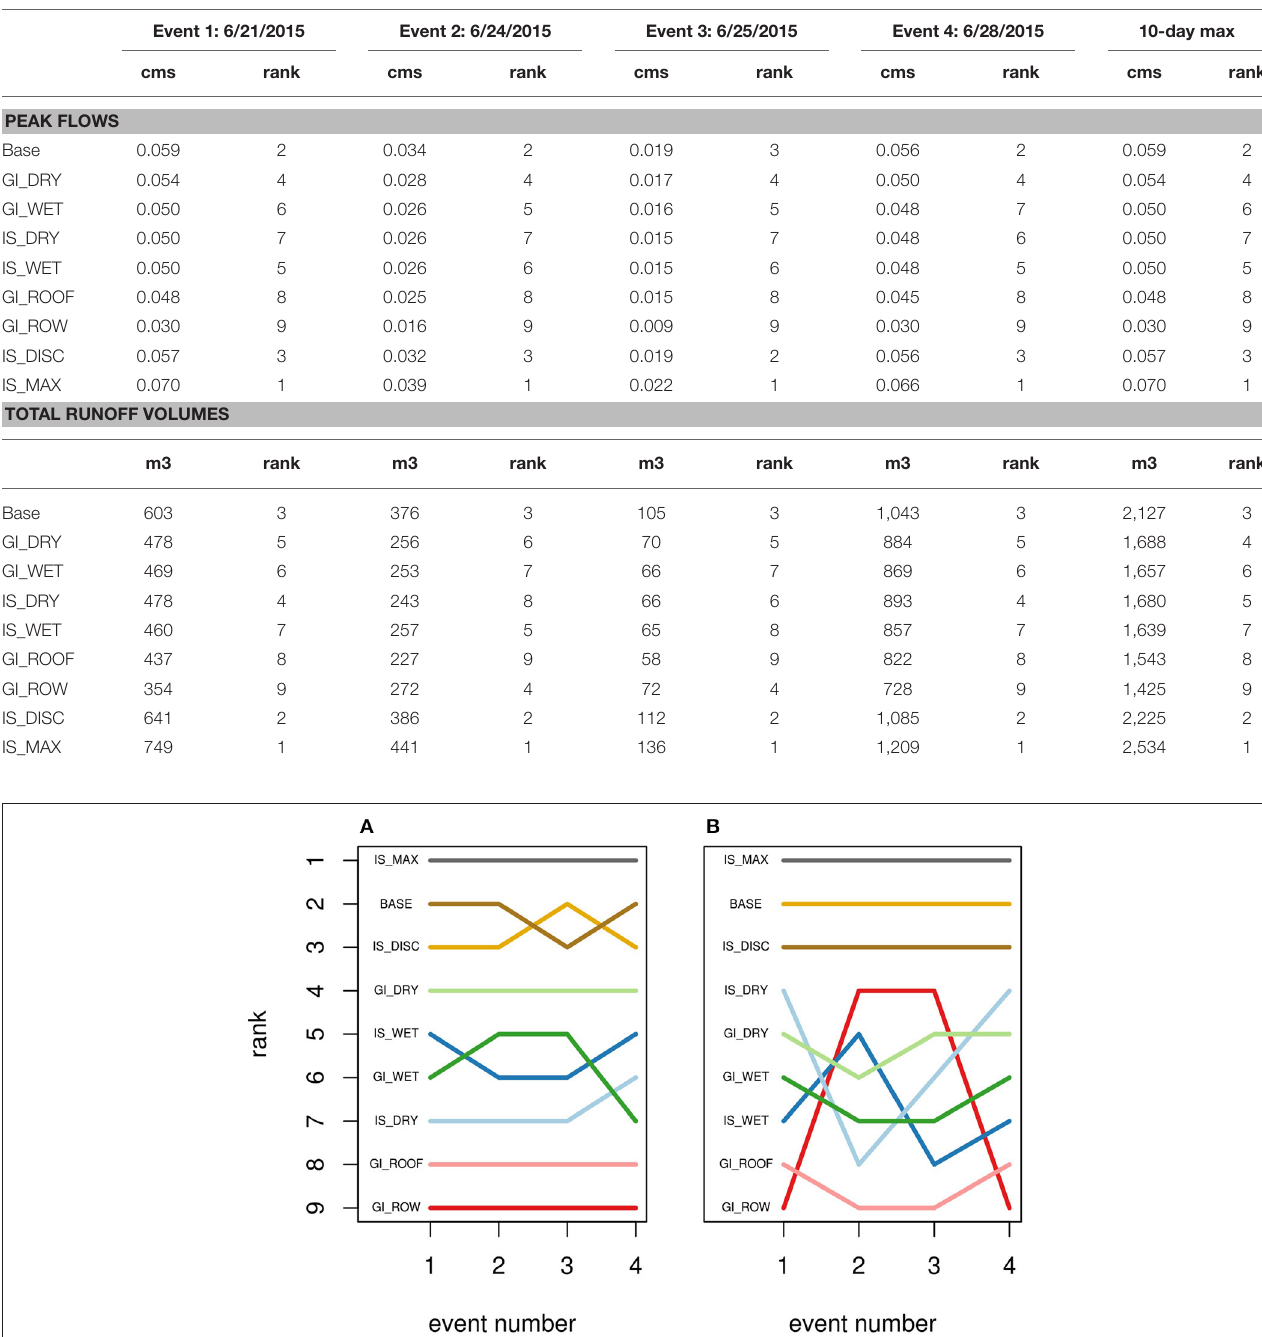
TABLE 2 | Scenario rankings for peak flows and total event volumes for four consecutive events in 10-day window.